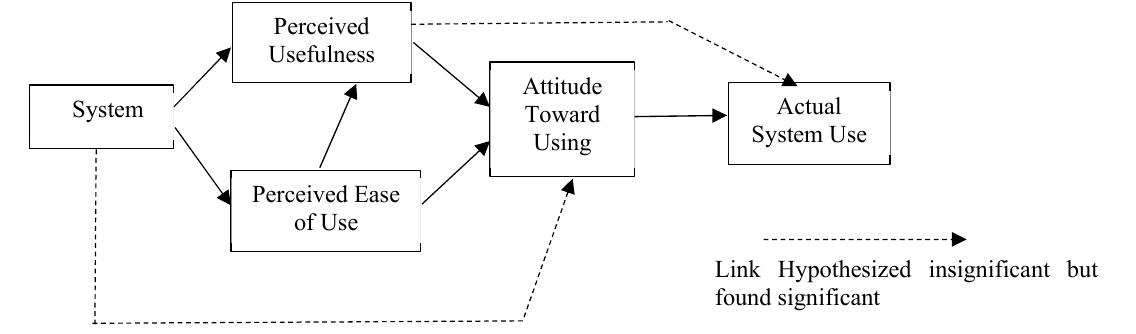
Fig. 2 Causal Diagram of Model Validation Results proposed by